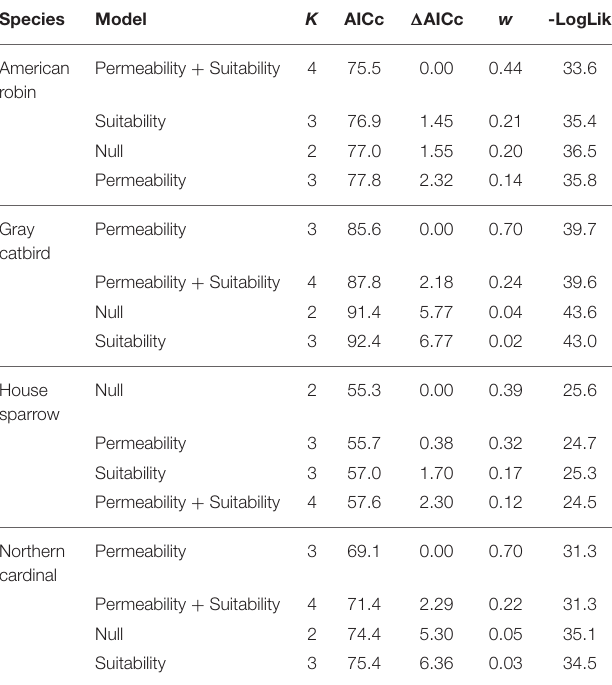
TABLE 3 | Model selection table for logistic mixed effects models describing the probability that settlement will occur between the banding station and a sampling location as a function of habitat suitability and permeability between the two points.